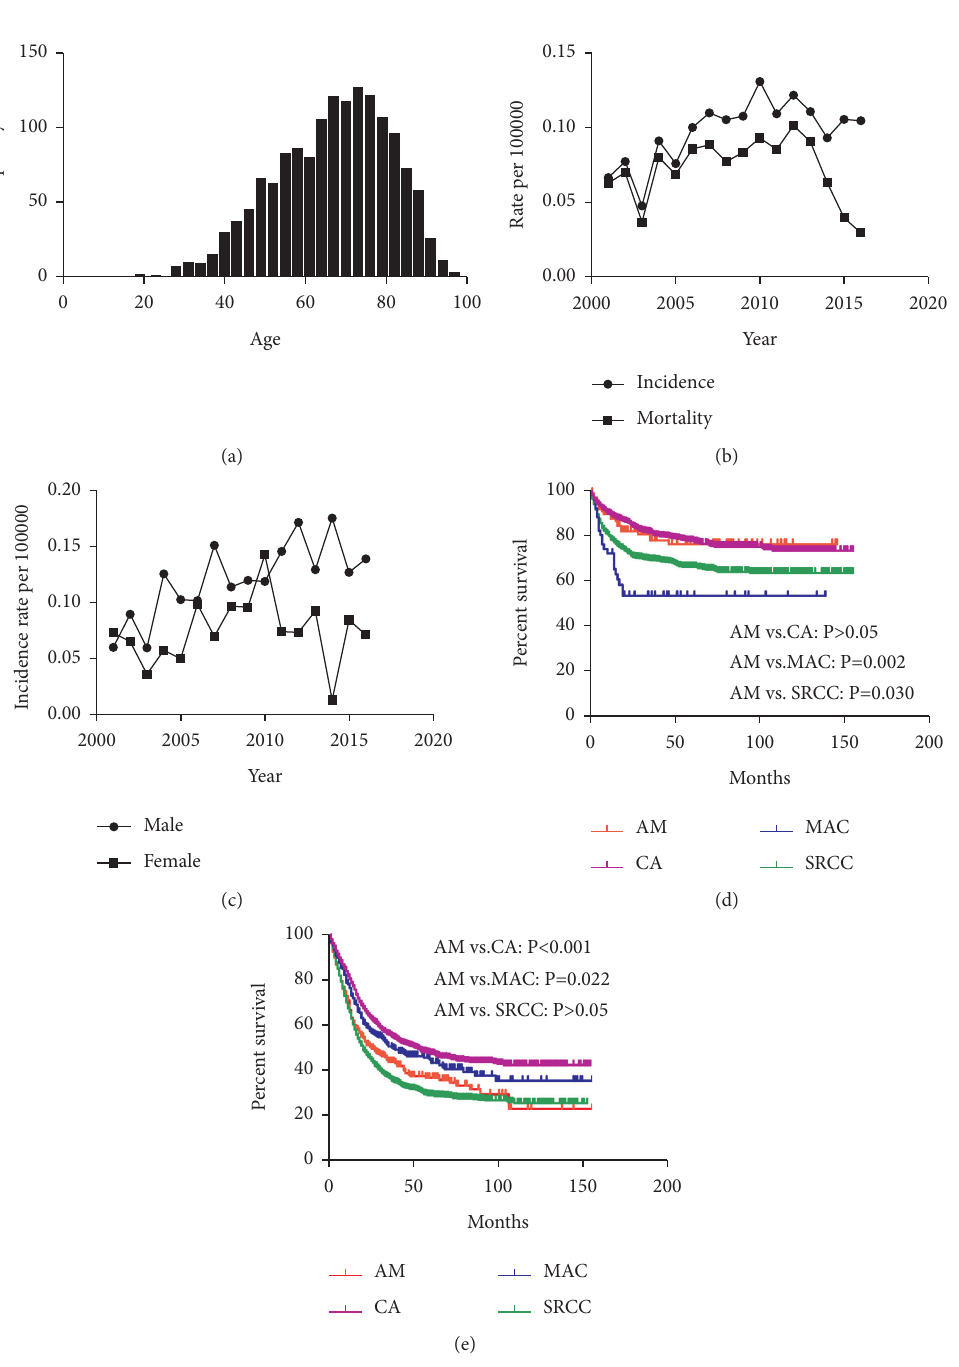
Figure 1: Incidence (a) of gastric cancer (GC) with adenocarcinoma with mixed subtypes (AM). The most common age at diagnosis was 72–74 years. Both the age-adjusted incidence rate and mortality rate of GC with AM (b). This increased trend (c) was similar regardless of sex. Comparisons of cancer-specific survival (d) in histological subtypes plotted with the Kaplan–Meier method in early gastric cancer (EGC). Comparisons of cancer-specific survival (e) in histological subtypes plotted with the Kaplan–Meier method in advanced gastric cancer